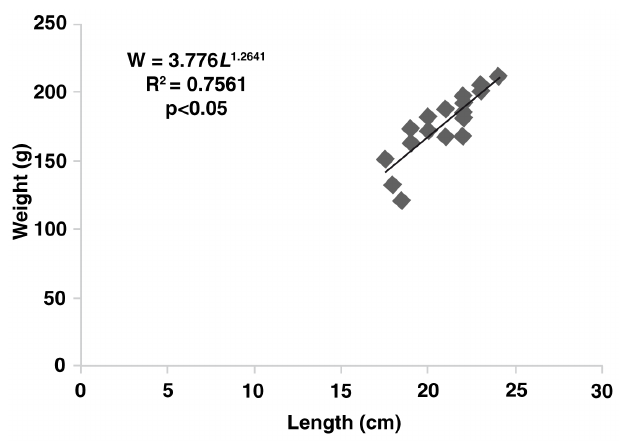
Figure 5. Total length-weight relationship for gurami sago cultured in earthen freshwater ponds. Each point represents one sampled fish ( N =24). The regression equation, coefficient of determination (R 2 ) and significance ( p -values) are also provided.